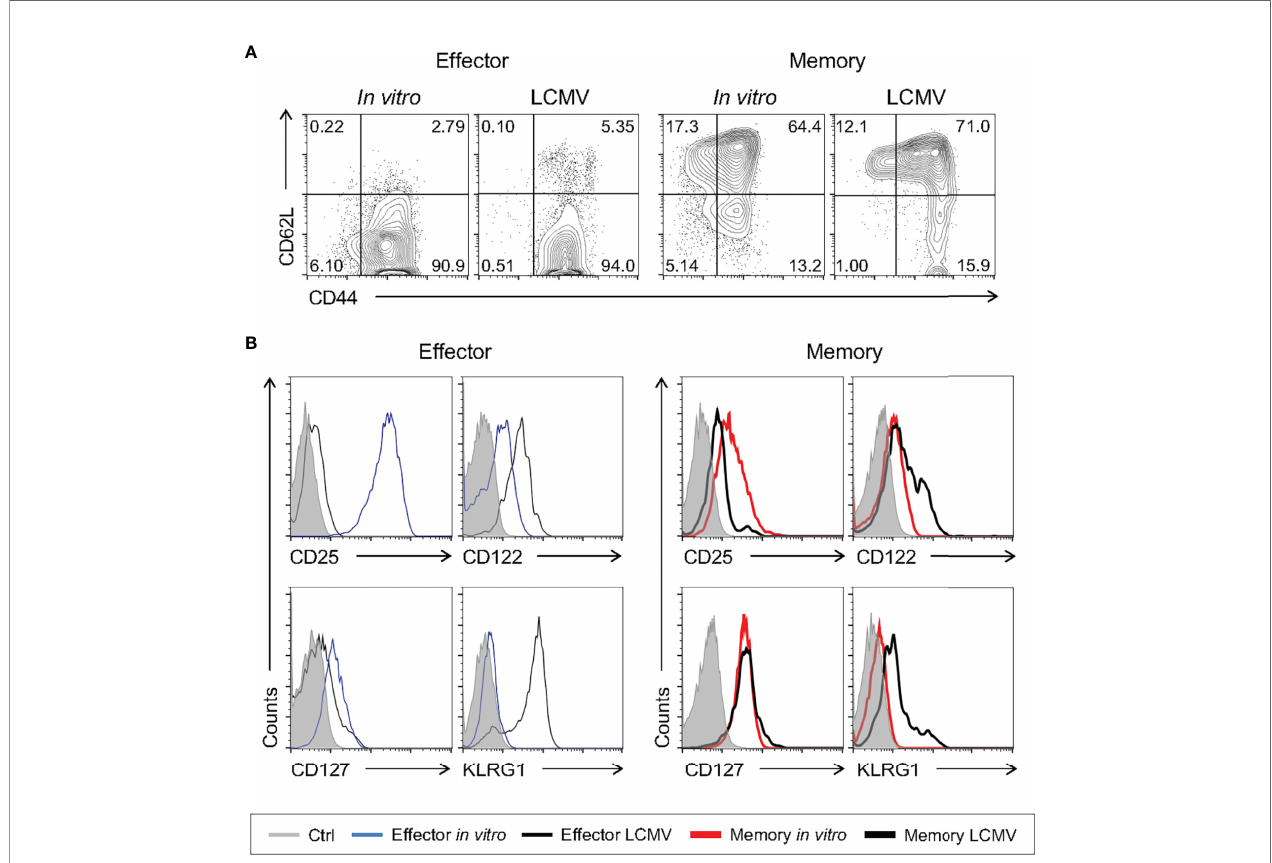
FIGURE 7 | In Vitro -Generated Memory-Like CD8 T Cells Are Phenotypically Similar to Virus-Induced Memory Cells. WT mice were infected i.p. with 2 x 10 5 PFU of LCMV Armstrong strain. The spleen cells were harvested 8 (effector) and 33 (memory) days after infection and compared to the respective in vitro CD8 T cell differentiation protocol. (A) Comparison between the levels of CD62L and CD44 in gp33-tetramer + effector and memory CD8 + T cells from the LCMV infection. Lymphocytes were labeled with anti-CD44 and anti-CD62L fl uorescently labeled monoclonal antibody. (B) Histograms of anti-CD25, anti-CD122, anti-CD127 and Klrg1 staining from unlabeled (gray), effector (thin black) and memory (thick black) cells from LCMV infection (gp33-tetramer + CD8 + ) and effector (thin blue) and memory (thick red) cells from the in vitro differentiation protocol. The results are representative of 5 to 11 infected